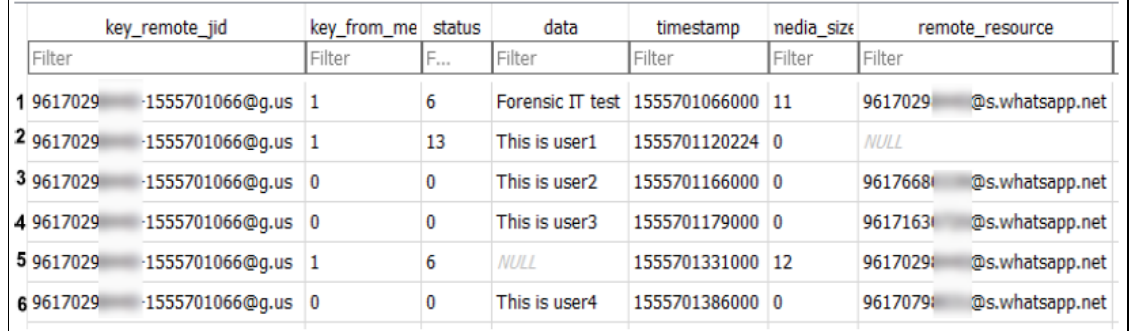
Figure 23. Groups chat records in chat database